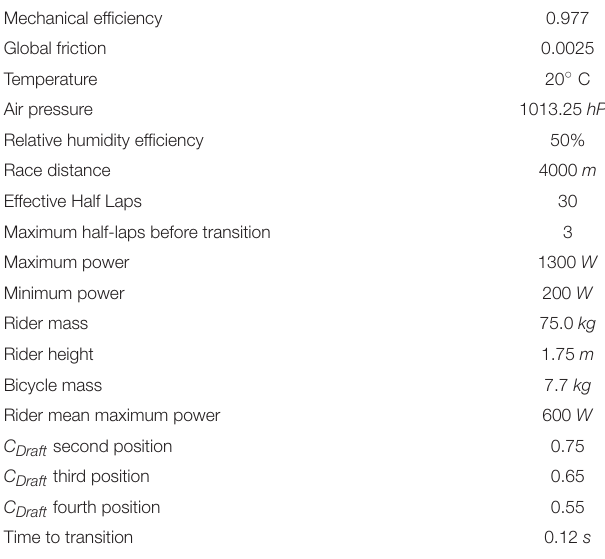
TABLE 1 | Problem